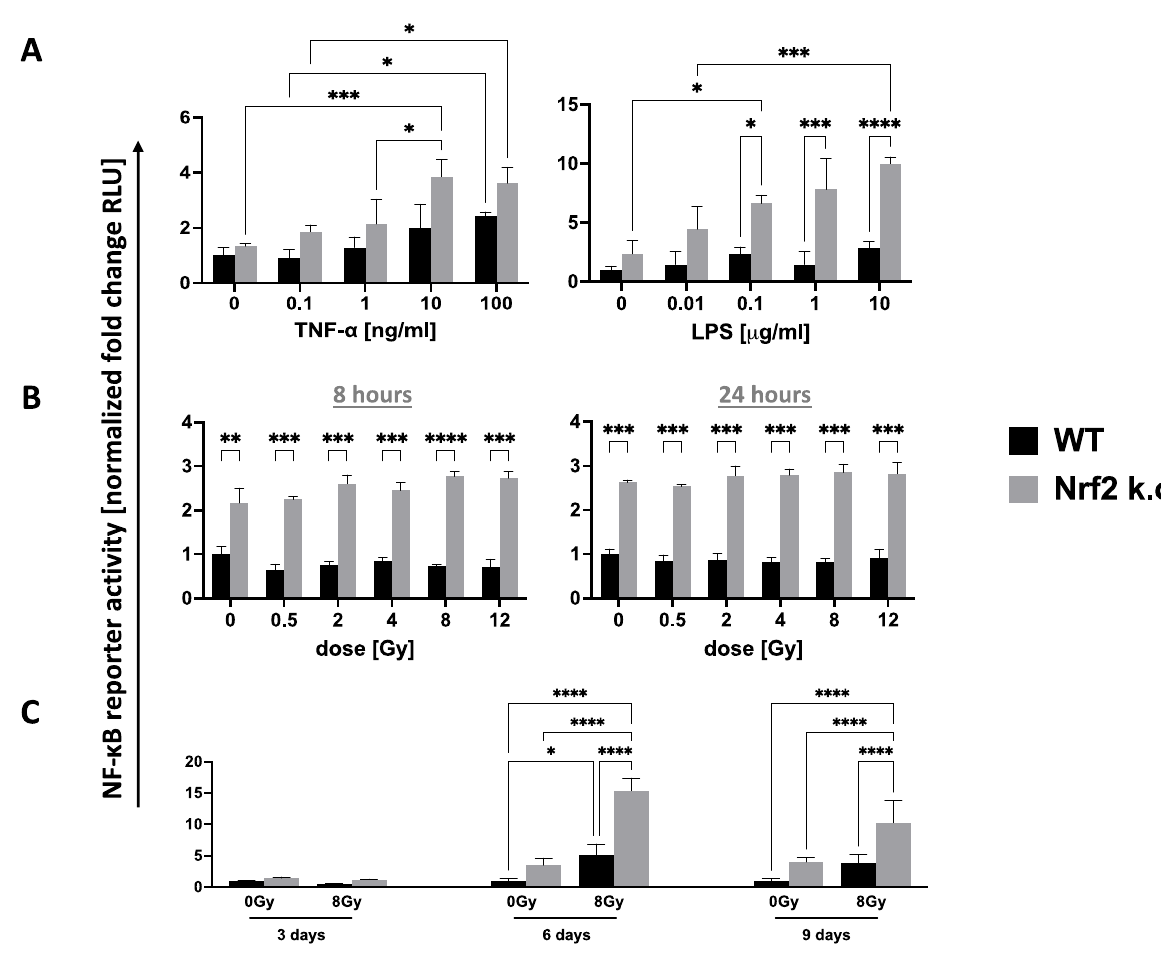
Figure 2. An NF- κ B-luciferase reporter gene was transfected into long-term Nrf2 –/– and WT MEFs and stimulated with ( A ) TNF or LPS, or ( B ) IR at indicated doses. TNF- α and LPS gave positive dose-dependent responses after 8 h ( A ) but not after IR at 8 or 24 h ( B ), which required several days ( C ). In general, responses were more pronounced in Nrf2 –/– MEFs. Data are mean ± s.d. of n = 3–4; representative of 2 experiments. * p < 0.05, ** p < 0.01, *** p < 0.001, **** p <